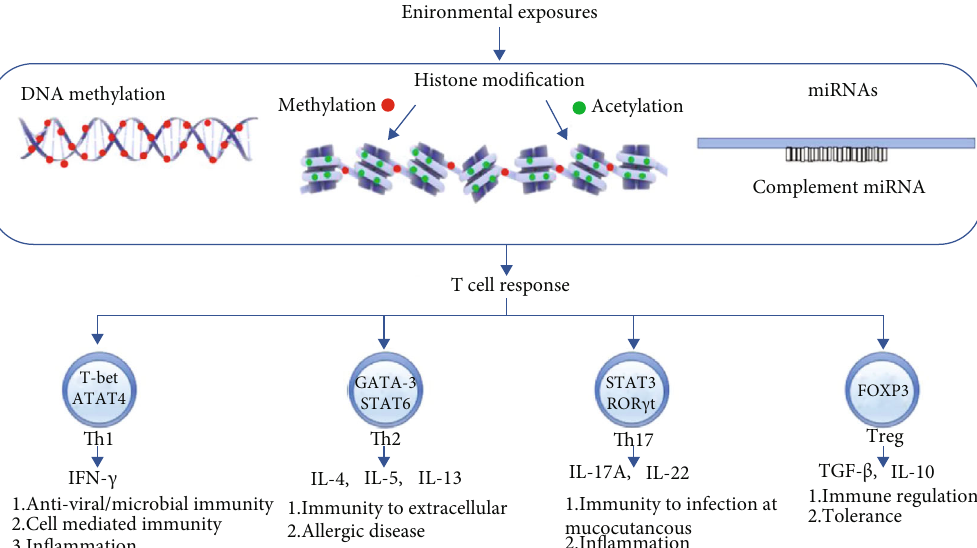
Figure 2: The role of epigenetics in the pathogenesis of asthma. An epigenetic mechanism links genetic and environmental factors with developmental trajectories in asthma. The most commonly studied asthma epigenetic phenomena are DNA methylation, histone modi fi cations, and miRNAs. DNA methylation is the process of adding methyl groups, by DNA methyltransferase, on cytosine at position 5 with the formation of 5-methylcytosine [18] where guanine nucleotide follows the cytosine nucleotide known as CpG [19]. The methylation of CpG islands (clusters of CpG) results in gene activation or inhibition, but usually repression, because the islands are found almost near the genes ’ transcription start site (TSS) [23]. Histone modi fi cation usually occurs at N-terminal with possible modi fi cations on each “ basic ” residue, but common residue targets for modi fi cations are lysine, serine, arginine, and tyrosine threonine. Acetylation, methylation, phosphorylation, ubiquitination, and sumoylation are well-known histone modi fi cation mechanisms. Histone acetylation and histone methylation are the most studied and better known to us [82]. Histone acetyltransferases (HATs) and histone deacetylases (HDACs) work in opposition to each other as acetylation by HATs favors gene expression and deacetylation by HDACs is responsible for gene silencing. The addition of phosphate, i.e., phosphorylation, is mediated by kinases, while phosphatases remove the phosphate. Similarly, histone ubiquitination is mediated by ubiquitin ligases and opposed by ubiquitin-speci fi c peptidases, also known as deubiquitinating enzymes. Histone sumoylation is mediated by the histone sumoylation proteins, also known as the small ubiquitin-like modi fi er (SUMO) protein. A microRNA (miRNA) is a 22-25 nucleotide single-stranded small noncoding RNA molecule transcribed from the DNA. However, miRNAs are not translated into proteins and play a role in gene expression either by blocking or by altering mRNA translation stability [86]. Alteration in epigenetic status results in di ff erential gene expression related to cytokines and transcription factors, resulting in various and distinct phenotypic presentations in asthma. Some T cell subsets and cytokine production and functions are also shown in the fi gure. miRNAs: micro-RNAs; Th cells: T helper